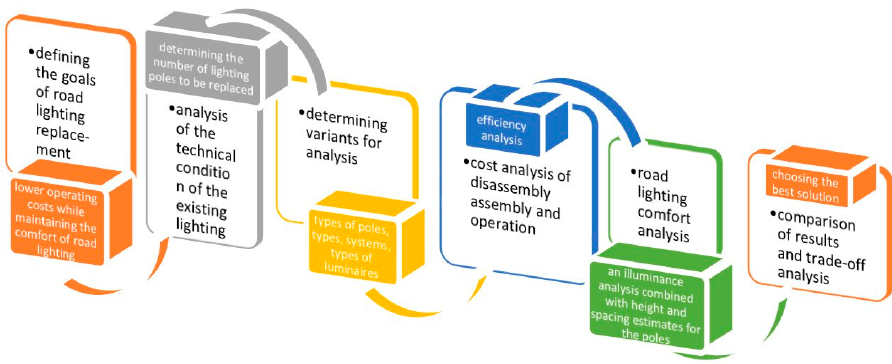
Figure 1. A simplified procedure in the method for analysing the effectiveness of road lighting system replacement and user comfort (source: original work).